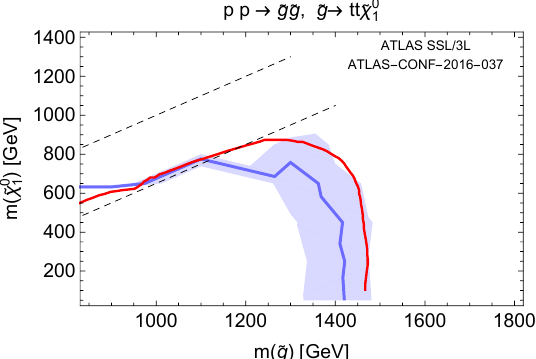
Figure 8 . Limits on a supersymmetric simpli(cid:12)ed model from our recasted search of [32] (blue line) with 50% error on the number of events in the signal regions (blue shaded region), compared to the experimental results (red line).